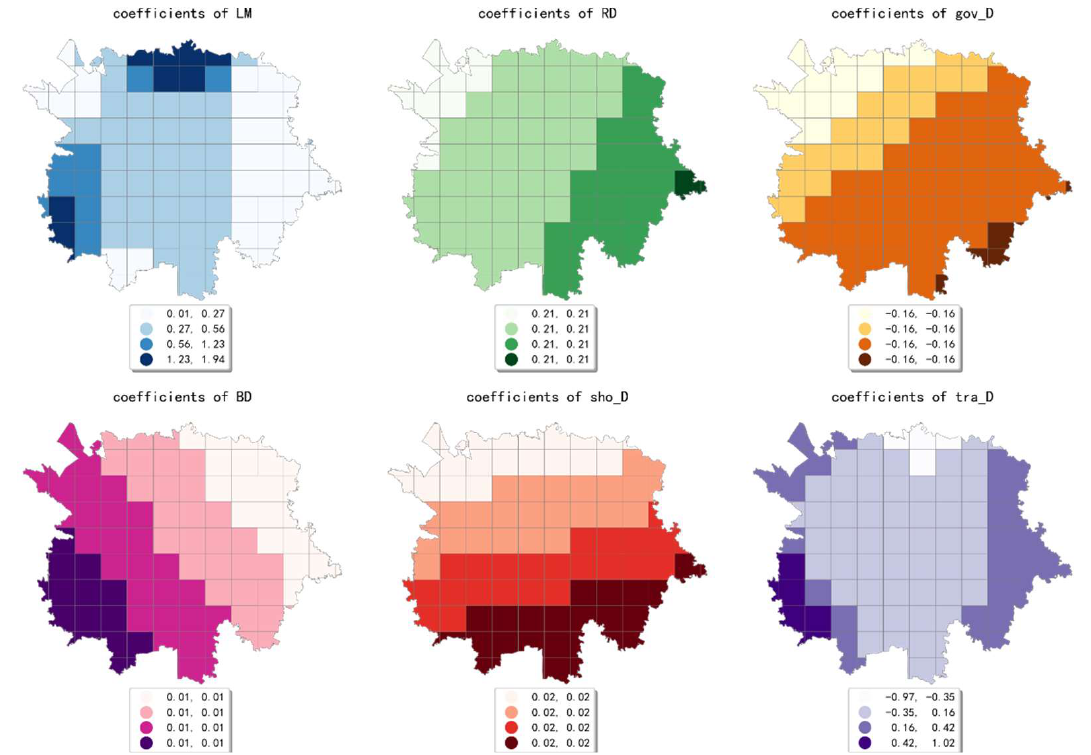
Figure 8. The estimated coefficient maps in the grid with 3500 m.